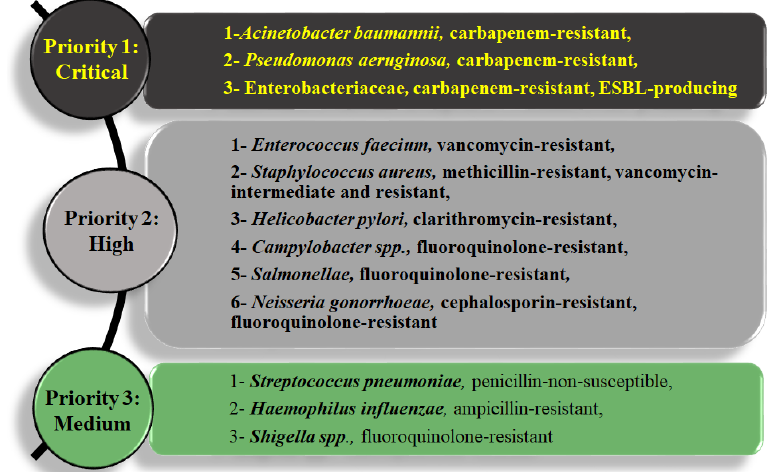
Figure 1. WHO list of priority pathogens in most urgent need for antimicrobial development